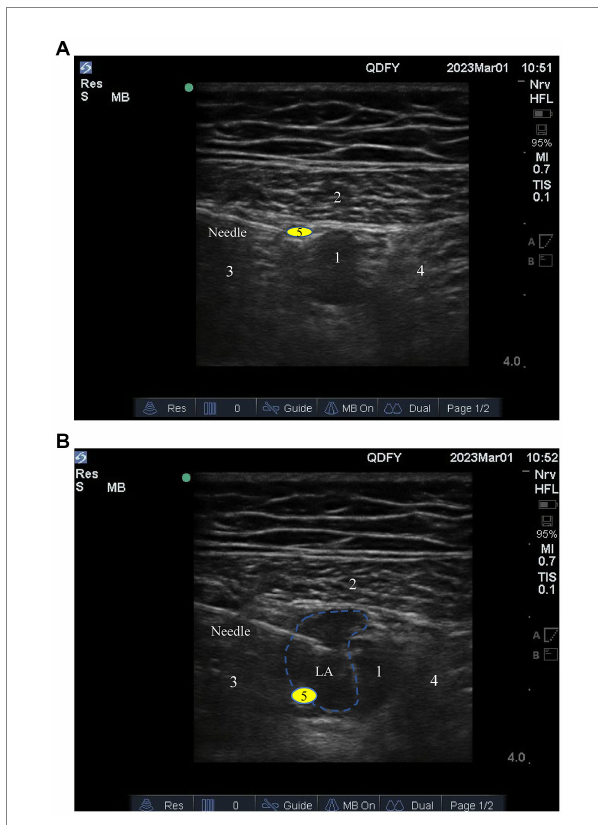
FIGURE 3 (A) The target for ultrasound-guided adductor canal block; (B) Diffusion of local anesthetic drugs within the adductor canal. 1, Femoral artery; 2, Sartorius muscle; 3, Medial vastus muscle; 4, Adductor magnus; 5, Saphenous